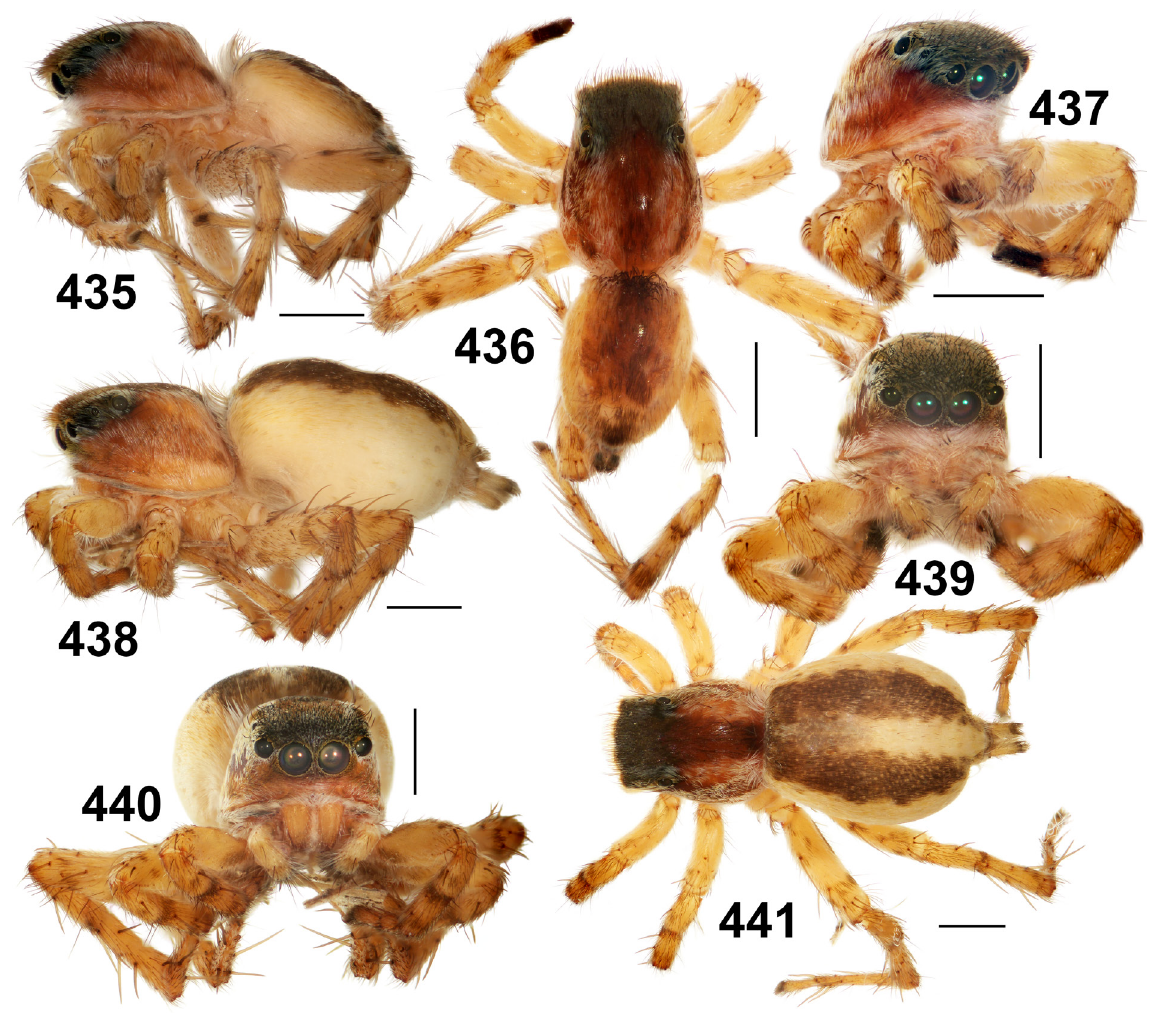
Figs 435–441. Stenaelurillus senegalensis sp. nov., paratypes, general appearance. 435–437 , 439 . ♂. 438 , 440–441 . ♀. Scale bars: 1